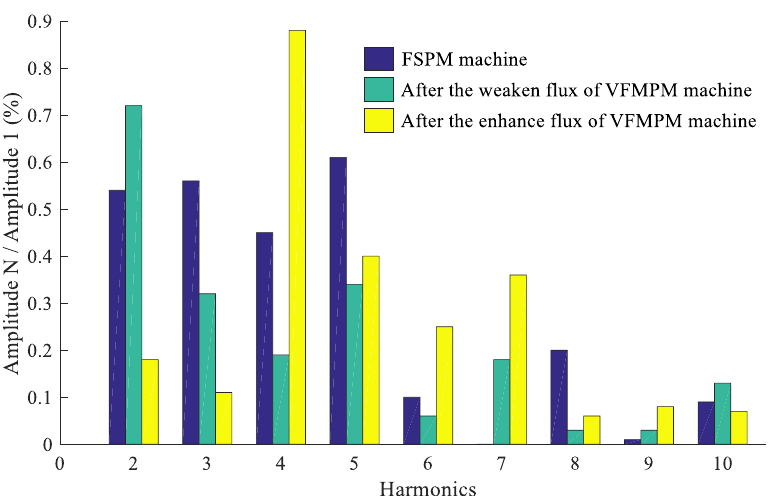
Figure 11. Harmonics comparison of back EMF waveforms of the FSPM machine and VFMPM machine.